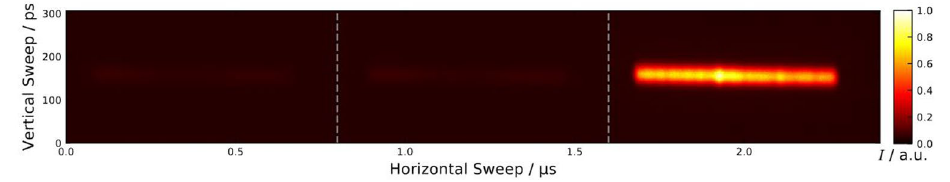
Figure 4. Images from the BESSY II streak camera 10 during the experiments demonstrating single island population of TRIBs. Here only rays in the visible from one of the three source points was accepted by the optics leading to a streak at only one of the three turns (here the third one) at a purity of 94% as demonstrated by the very dark background signals from the other two previous turns (< 1.6 µs). The vertical width of the streak corresponds to the bunch length of 50 ps [FWHM] averaged over all bunches in the filling